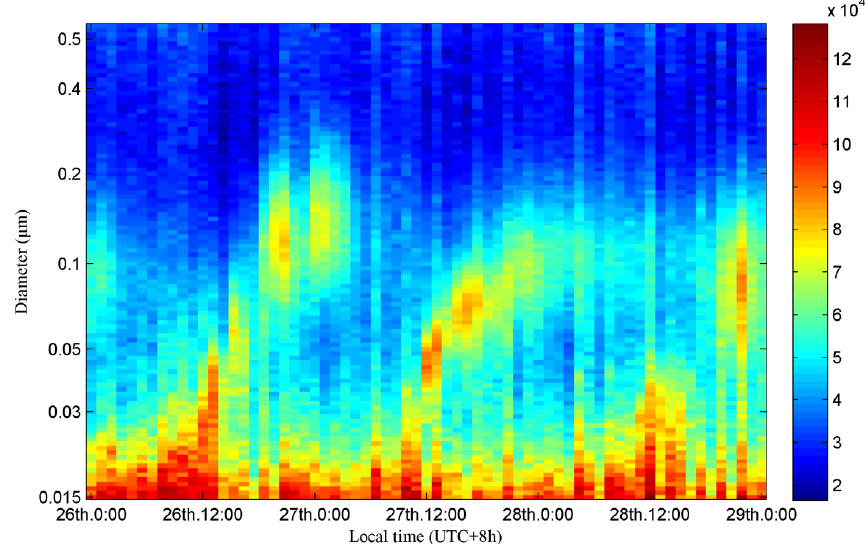
Figure 7. Contour plot of size distribution of number concentration on three consecutive days based on particle diameter (color bar scale: d𝑁/dlog 𝐷 𝑝 in cm −3 ).